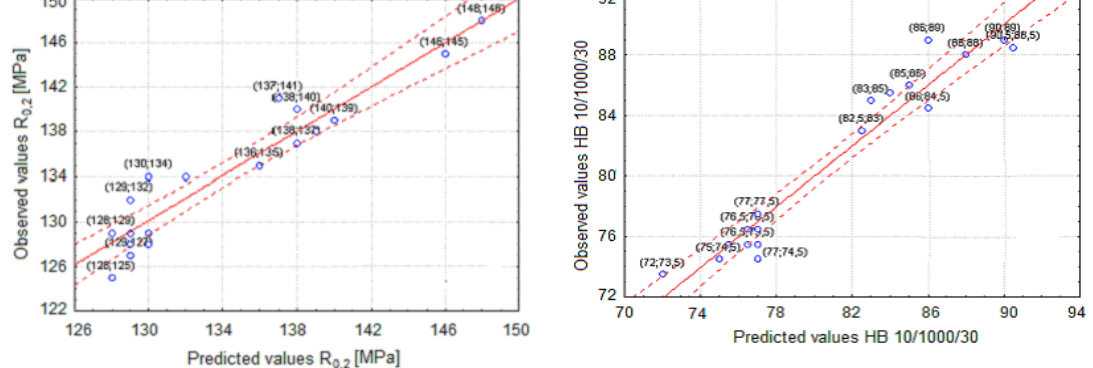
Fig. 4. Diagram of predicted and observed values for the variable R